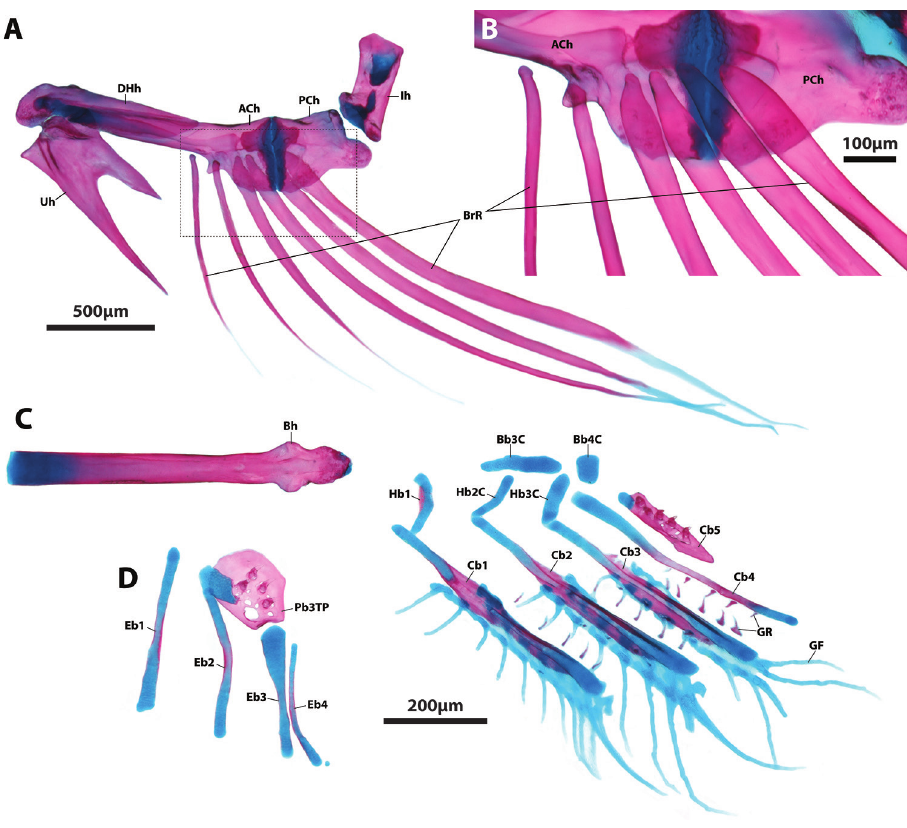
Figure 8. Hyoid bar ( A–B ) and gill arches ( C–D ) of Flexor incus, AIM MA655142, paratype, 20.0 mm SL. A Hyoid bar, right side in lateral view (image reversed) B Close up of box in A showing articulating between heads of branchiostegal rays and hyoid bar C Lower gill arches in dorsal view, paired elements of right side omitted D Upper gill arches of left side in ventral view. A single scale bar shared between C and D . Abbreviations: ACh, anterior ceratohyal; Bb3-4C, basibranchial 3 or 4 cartilages; Bh, basihyal; BrR, branchiostegal rays; Cb1-5, ceratobranchial 1-5; DHh, dorsal hypohyal; EB1-4, epibranchials 1-4; GF, gill filament; GR, gill raker; Hb1, hypobranchial 1; Hb2-3C, hypobranchial 2 or 3 cartilage; Pb3TP, pharyngobranchial 3 toothplate; Uh,